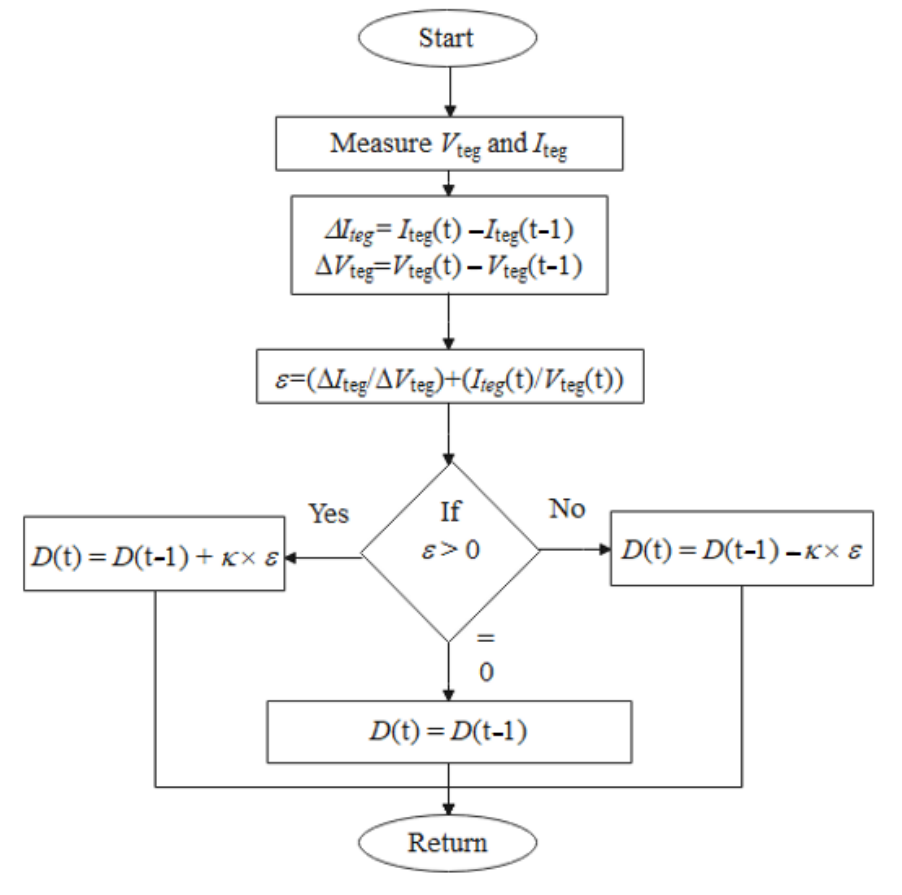
Figure 2. Flowchart of conventional INR method.